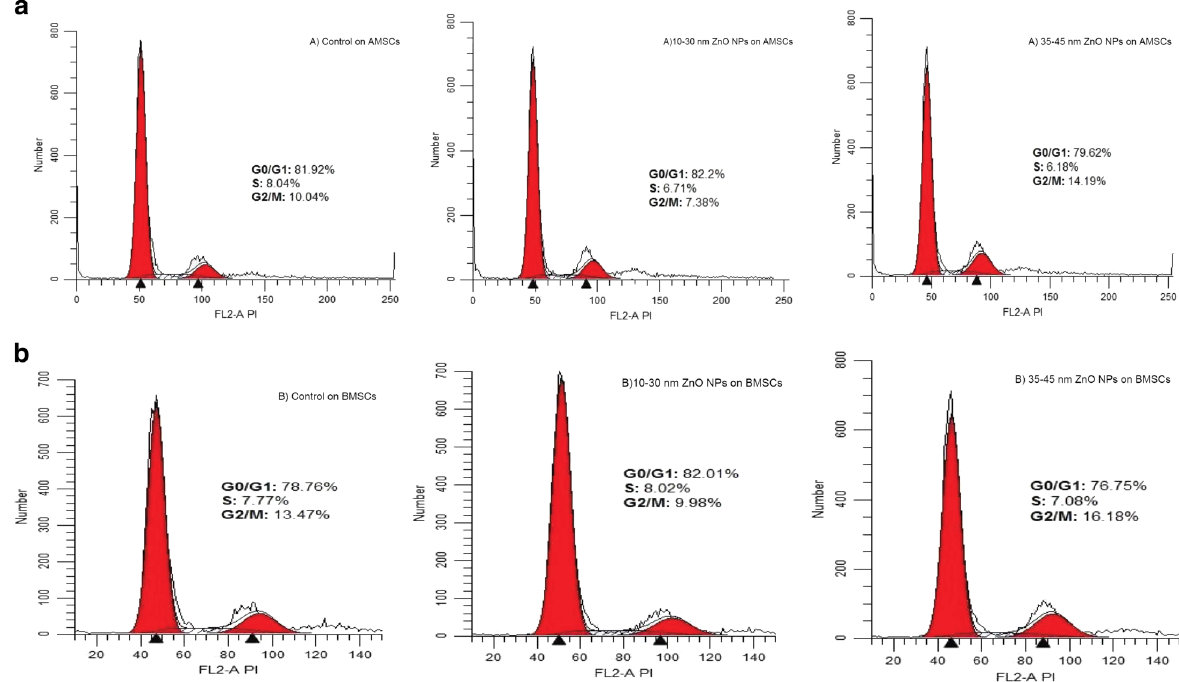
Fig. 4 Cell-cycle analysis following fl ow cytometry of the cells with 5 and 10 µg/ml transfections for 10 – 30 and 35 – 45 ZnO NPs, respec- tively. a The AMSCs exposed to 10 – 30 ZnO NPs represented fewer